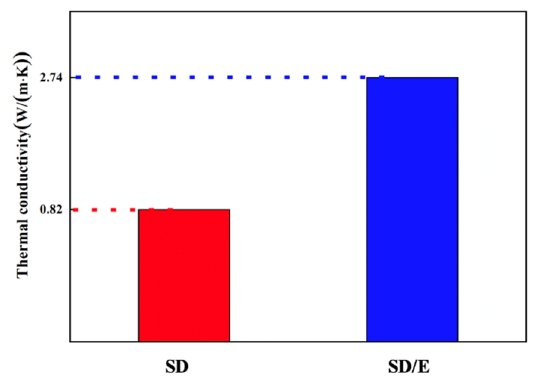
Figure 6. Thermal conductivity of SD and SD/E.